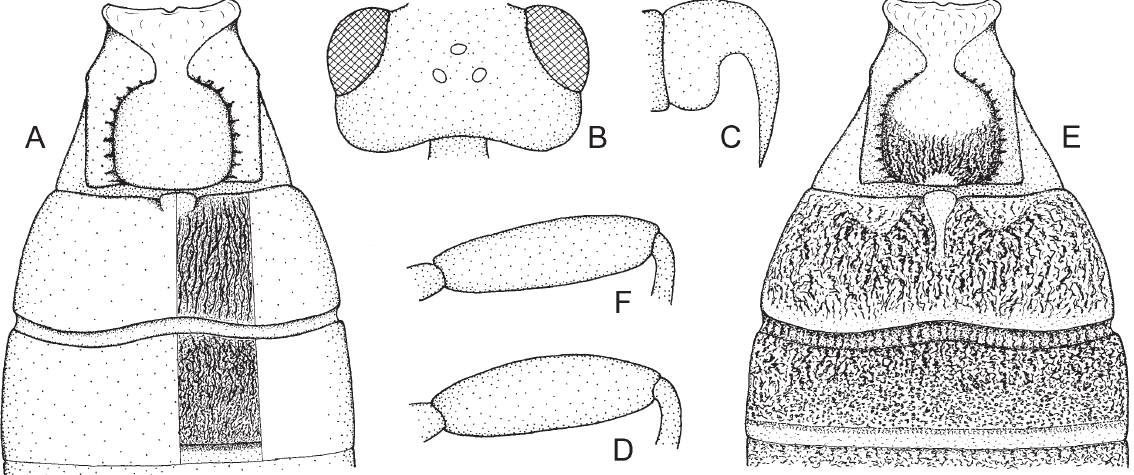
Fig. 34. — A . Bracon ( Bracon ) pectoralis Wesmael, 1838, ♂ paralectotype, tergites 1-3. — B-D . Bracon ( Bracon ) mellitor Say, 1836, ♀ / ♂. B . Head in dorsal view. C . Claw. D . Hind femur. — E-F . Bracon ( Bracon ) luteator Spinola, 1808. E . Tergites 1-3 (♀). F . Hind femur (♀ /